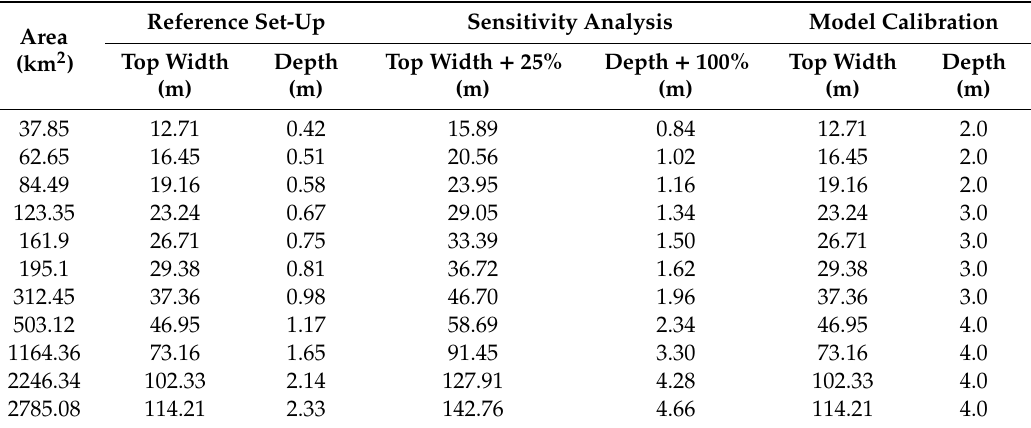
Table 1. Cross-section drained area, width, and